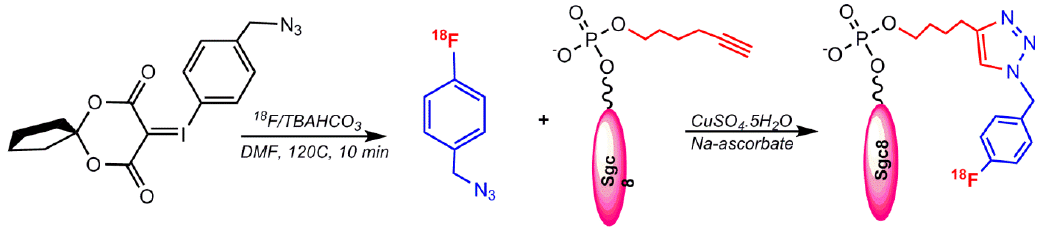
Figure 10. Conjugation of 1 ‐ (azidomethyl)–4 ‐ (fluoro– 18 F)benzene to a terminal hexynyl modified aptamer.